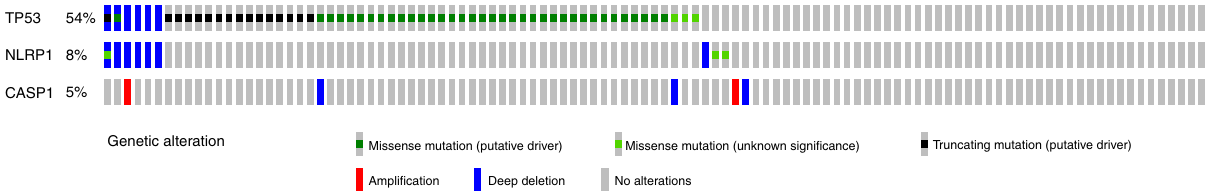
Fig. 2 Oncoprint of somatic alterations in TP53, NLRP1, and CASP1 in 109 microdissected human pancreatic cancers (original data from Witkiewicz et al. Nature Communications 2015). Black arrowhead indicates a tumor with NLRP1 deletion that is TP53 wild type. Open arrowheads indicate tumors with CASP1 deletion that are mutually exclusive with NLRP1